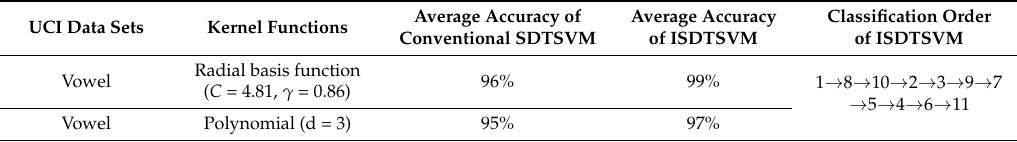
Table 2. The classification results of the UCI data sets using the Improved Skewness Decision Tree Support Vector Machine (ISDTSVM) and the conventional Skewness Decision Tree Support Vector Machine (SDTSVM) algorithm with different kernel functions and a five-fold